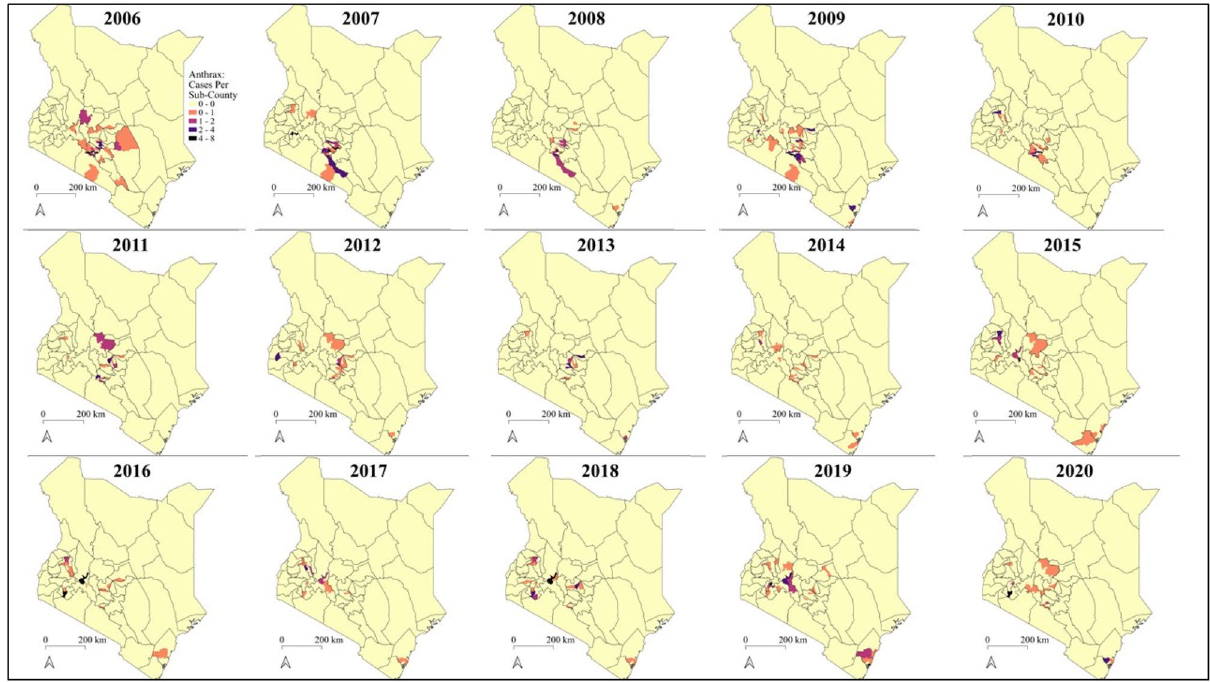
Figure 9. Spatiotemporal trends in confirmed livestock anthrax cases across Kenya. Maps illustrate the total reported livestock anthrax cases in each sub-county from 2009 to 2020. Map generated using Quantum Geographical Information Systems (QGIS) v. 3.16.11 (https:// www. qgis. org/ en/ site/ forus ers/ downl oad. html).